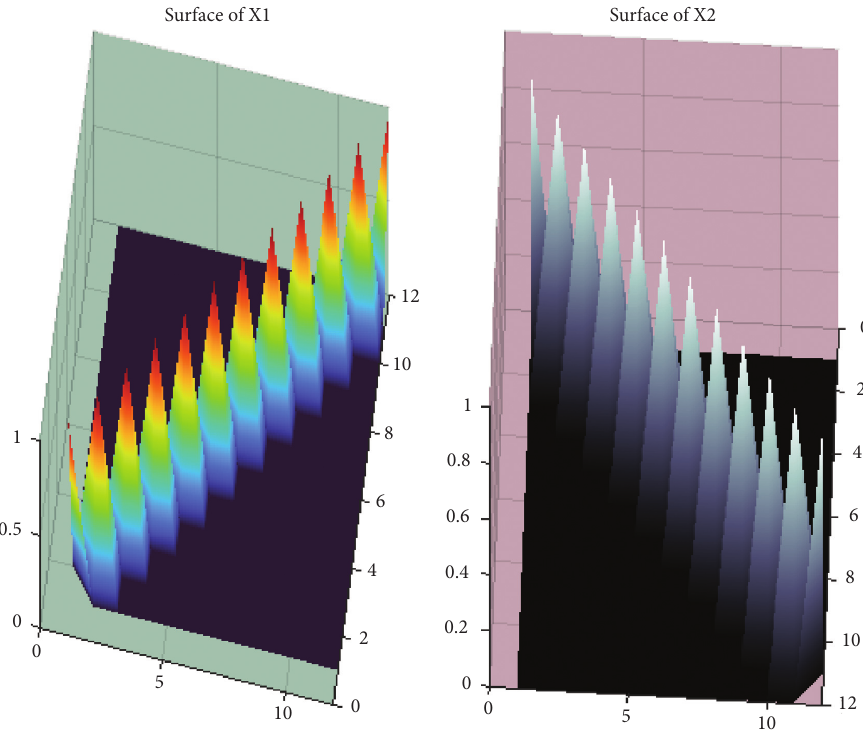
Figure 16: Solution surface plot for dimension 12.